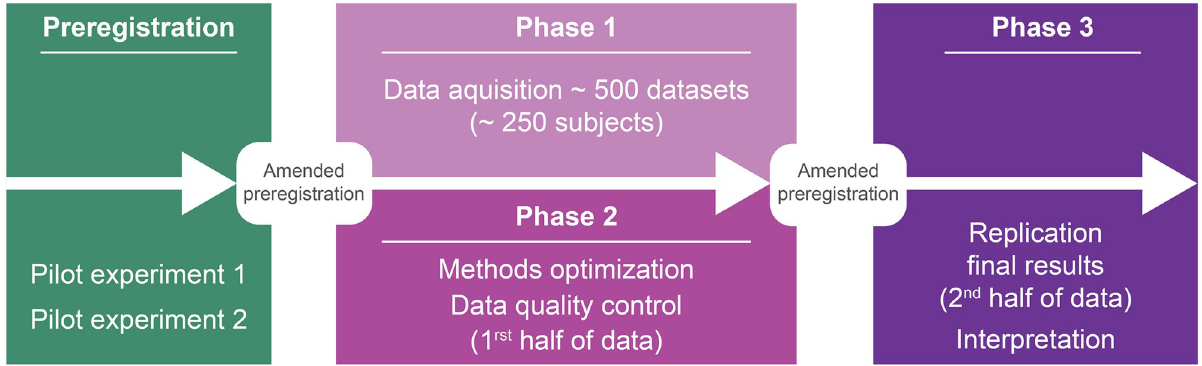
Fig 4. Timeline for the adversarial collaboration protocol. Number of subjects refers to the sum of subjects collected in the two experiments. Due to the COVID-19 pandemic of 2020–2021, phase 1 and 2 will be carried out in parallel and adjustments to the timing of some of the phases may be